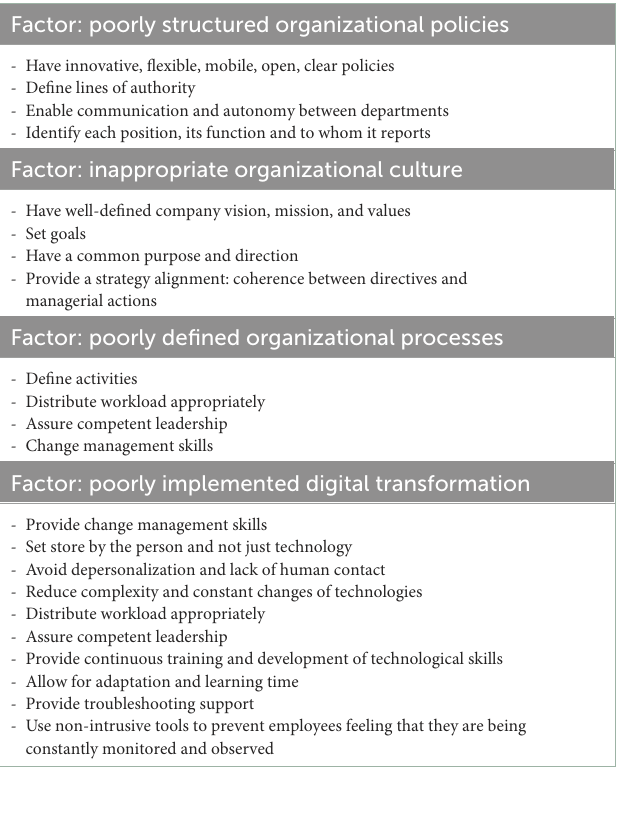
TABLE 11 Actions for each